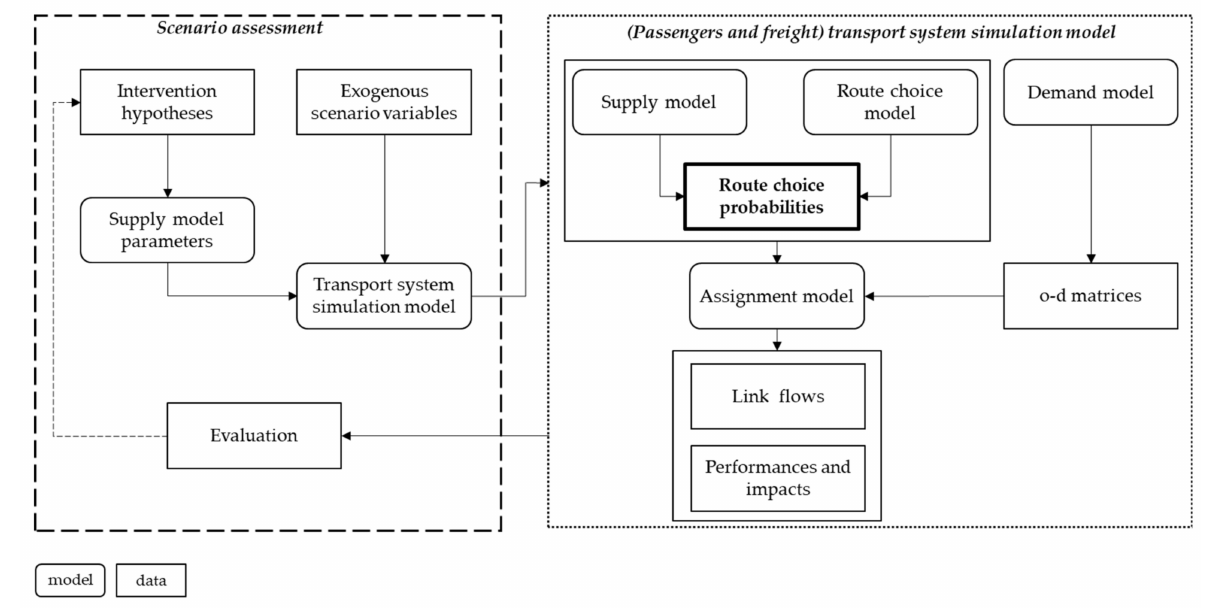
Figure 1. Proposed method: general